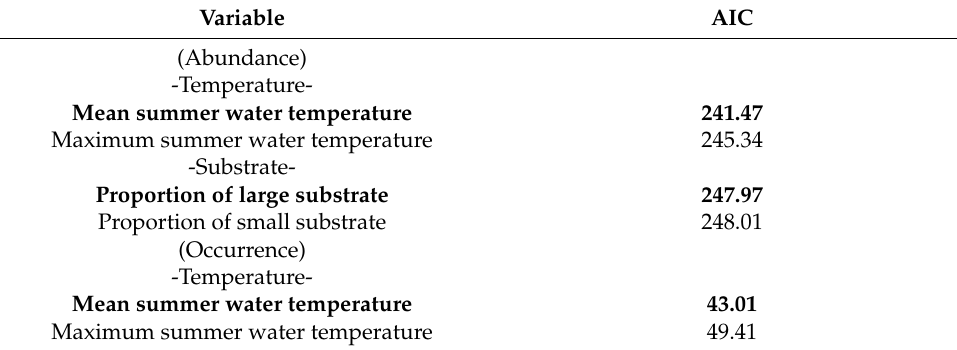
Table 1. Results of analyses for variable selection. Variables used in the statistical analyses are shown in bold. AIC indicates Akaike’s information criterion.